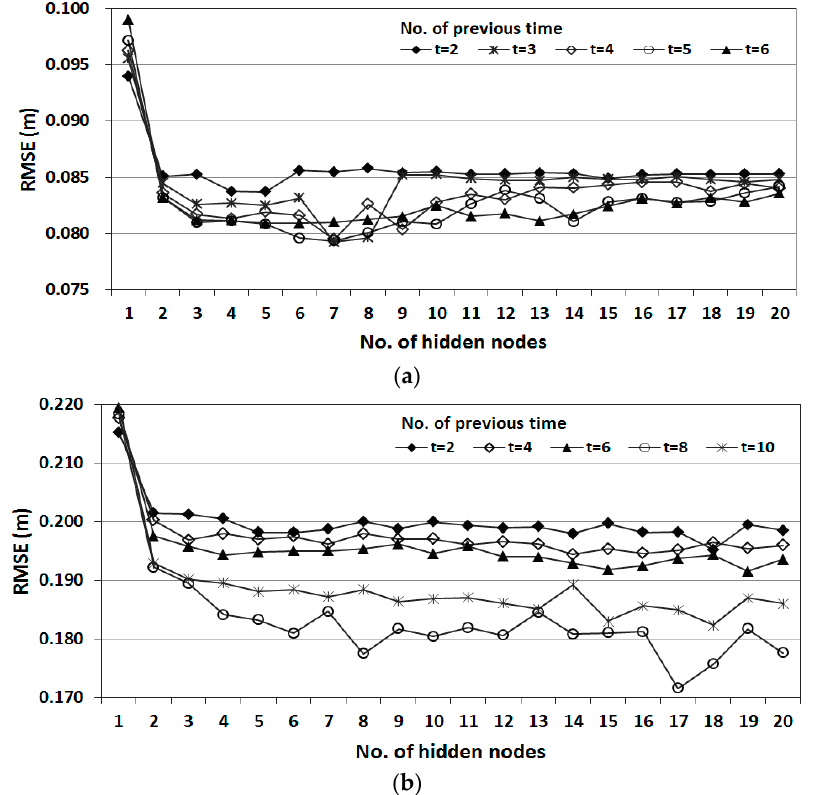
Figure 9. Root mean square error (RMSE) of ANN1a and ANN3c models according to the number of hidden nodes and previous time span. ( a ) ANN1a; ( b ) ANN3c.